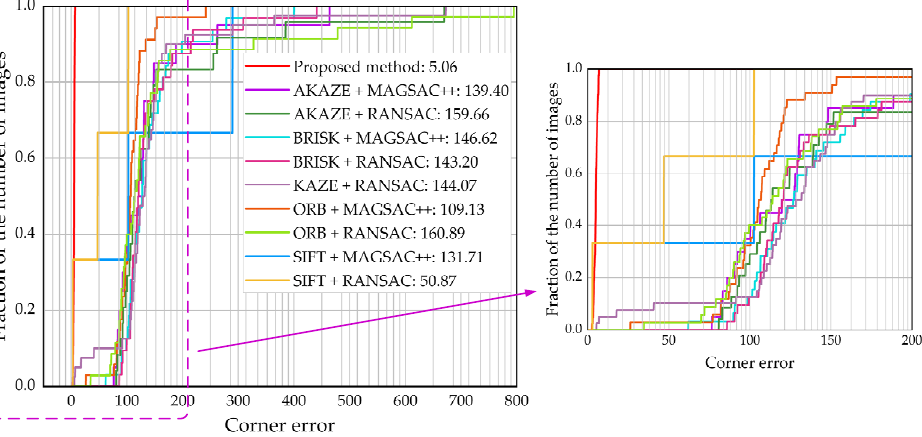
Figure 10. Quantitative comparison of HomoMGAN with feature-based methods in the synthetic benchmark dataset. The left side shows the evaluation results of our method and nine feature-based comparisons. The right side represents the local amplification result of the corner error [31] belonging to the range of 0 to 100.